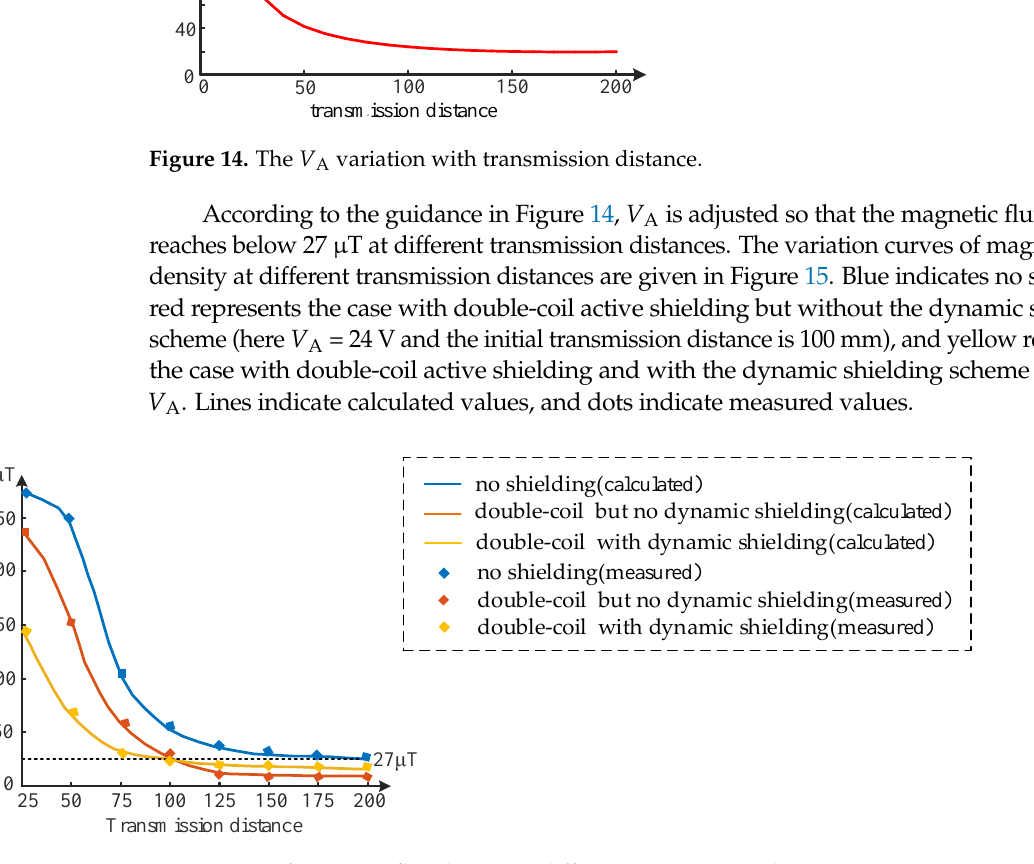
Figure 15. Curves of magnetic flux density at different transmission distances. It can be seen from the three curves in Figure 15 that the measured and calculated values are in general agreement. Without shielding, the magnetic flux density within 10–163 mm is higher than the safety limit of 27 µ T, and only in the range of 163–200 mm is it below the safety standard. When double-coil active shielding is used without the dynamic shielding scheme, the magnetic flux density is significantly higher than 27 µ T at a distance less than the initial transmission distance of 100 mm. The greater the distance, the greater the flux density. Obviously, at reduced distances, the initial supply power V A is not sufficient to shield the EMF leakage of the WPT system. Moreover, at a distance greater than the initial transmission distance, the magnetic flux density becomes gradually lower than the safety limit, when no corresponding adjustment of V A will also result in a waste of resources. When adopting double-coil active shielding and applying the dynamic shielding scheme to adjust V A , the EMF leakage can be basically kept below the safety limit of 27 µ T regardless of the increase in or shortening of the transmission distance. It avoids excessive power waste when the distance increases and solves the problem of excessive EMF exposure to human